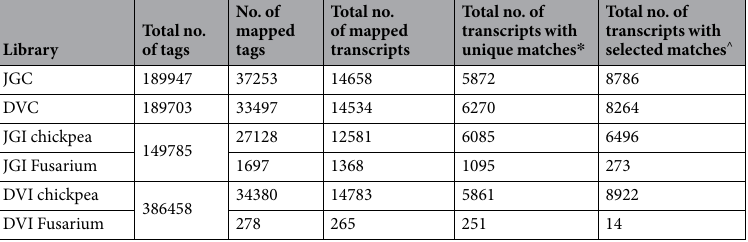
Table 1. Statistics of tag mapping of the four LongSAGE libraries. * ‘Unique’ match represents those tags mapped only on single transcript. ^ ‘Selected’ match represents multiple tag sequences mapped on the same